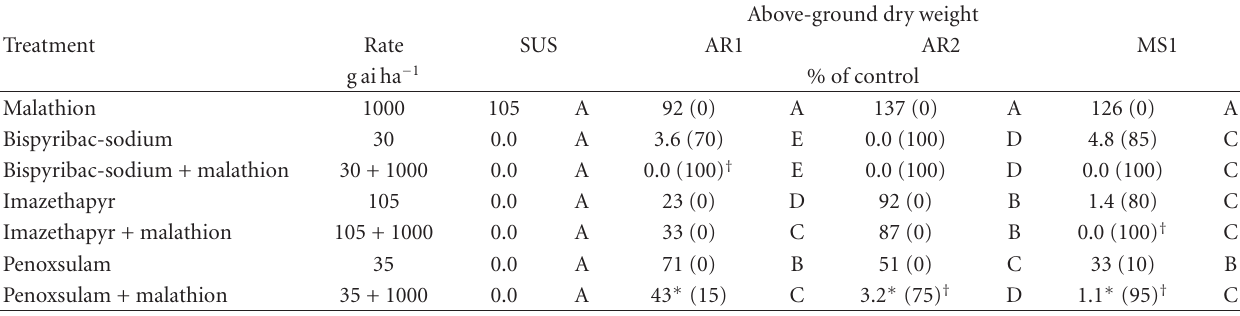
Table 4: The percent of above-ground dry weight (with percent mortality in parenthesis) of ALS-resistant (AR1, AR2, and MS1) and -susceptible E. crus-galli populations at 21 d after treatment with di ff erent ALS herbicides applied alone or in combination with malathion a,b,c,d,e